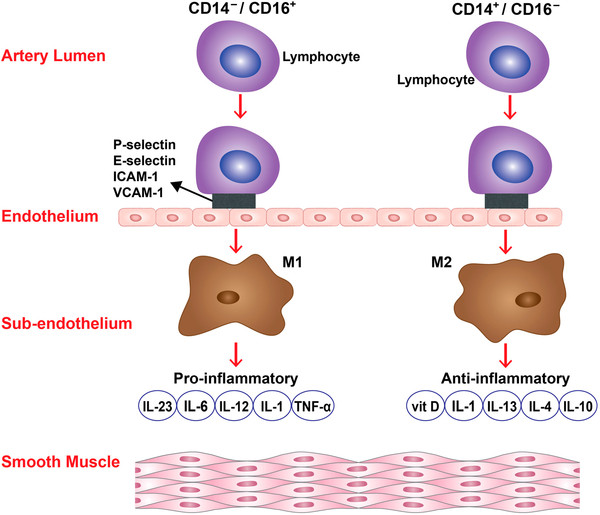
Polarized monocytes and cytokine production. Schematic diagram demonstrating two populations of monocytes (CD14high CD16low, CD14low CD16high) and their polarization to two subtypes of macrophages (M1 and M2) with their cell-specific cytokine production.